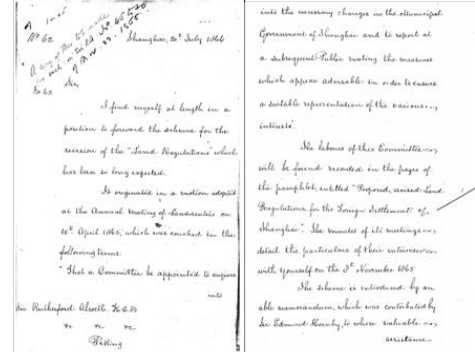
Figure 5 . Correspondence between Arleigh and Winchester (Source: THE NATIONAL ARCHIVIES,